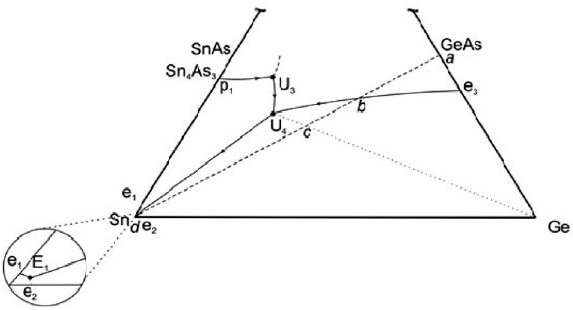
Figure 2. Crystallization processes of the alloys of the polythermal section Sn – GeAs.